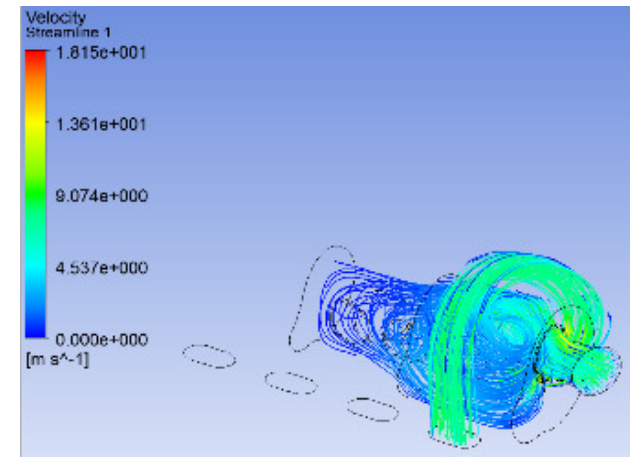
Fig. 12. Transient analysis for first runner output at (5 to 50 m/sec) inlet velocities